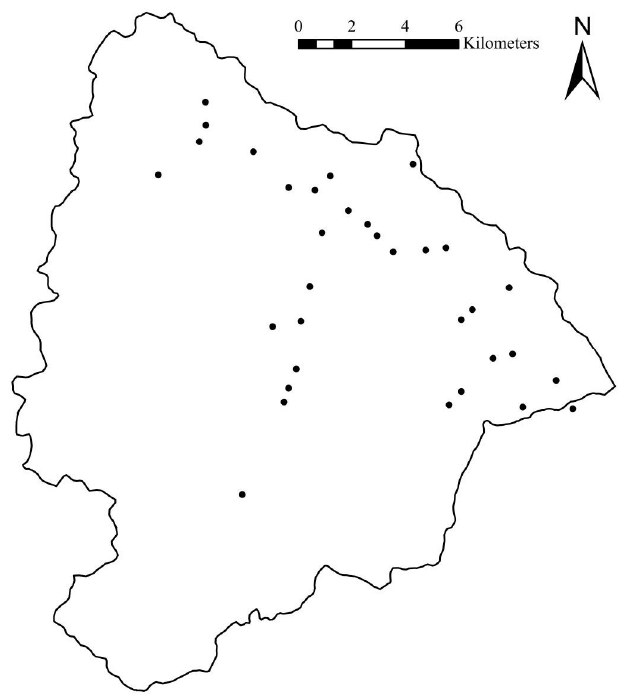
Figure 1. Distribution of Abies faxoniana (AF) plots in the Wanglang Nature Reserve.